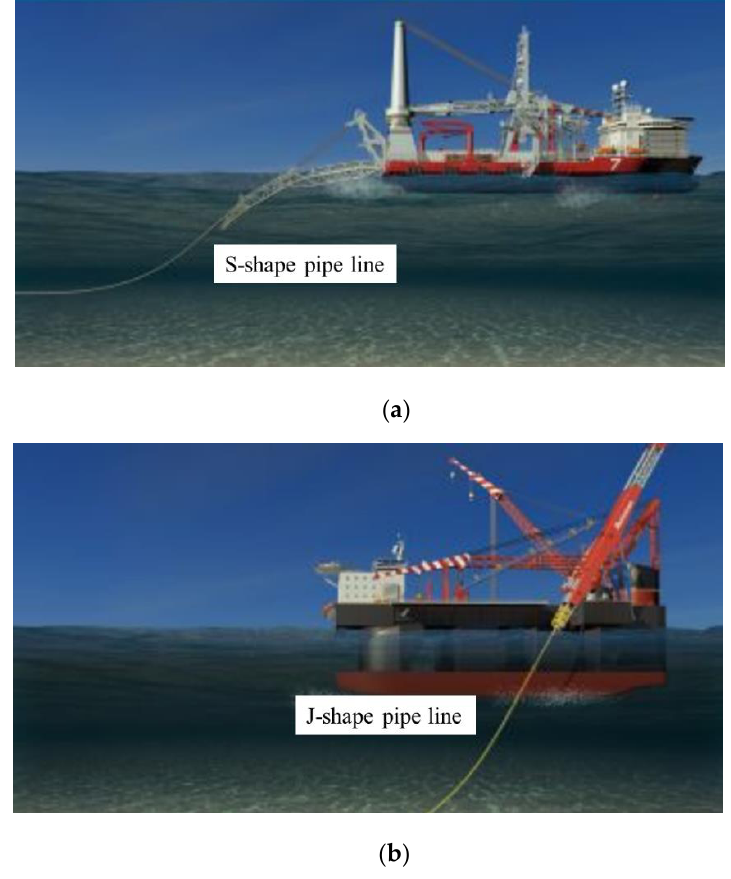
Figure 1. Integrated pipe lay systems: ( a ) S-lay system and ( b ) J-lay system.